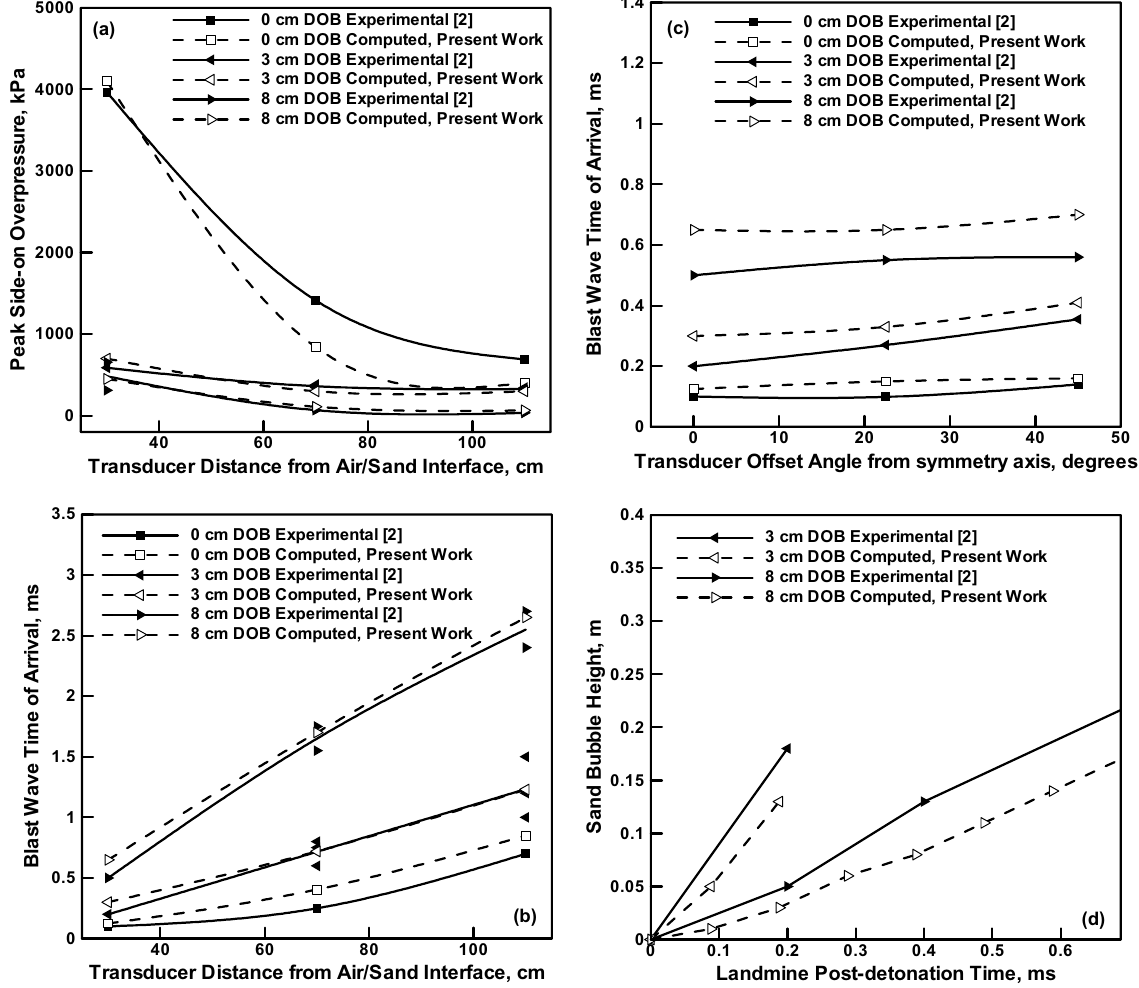
Fig. 9. A comparison of the experimental [2] and computed (present work) results pertaining to various phenomena associated with landmine detonationinfullysaturatedsand: (a)Side-onoverpressurevs.transducerdistancefromair/sandinterface; (b)Blastwavearrivaltimevs.transducer distance from air/sand interface; (c) Blast wave arrival time vs. transducer offset angle from the symmetry axis and (d) Sand bubble height vs. landmine post-detonation